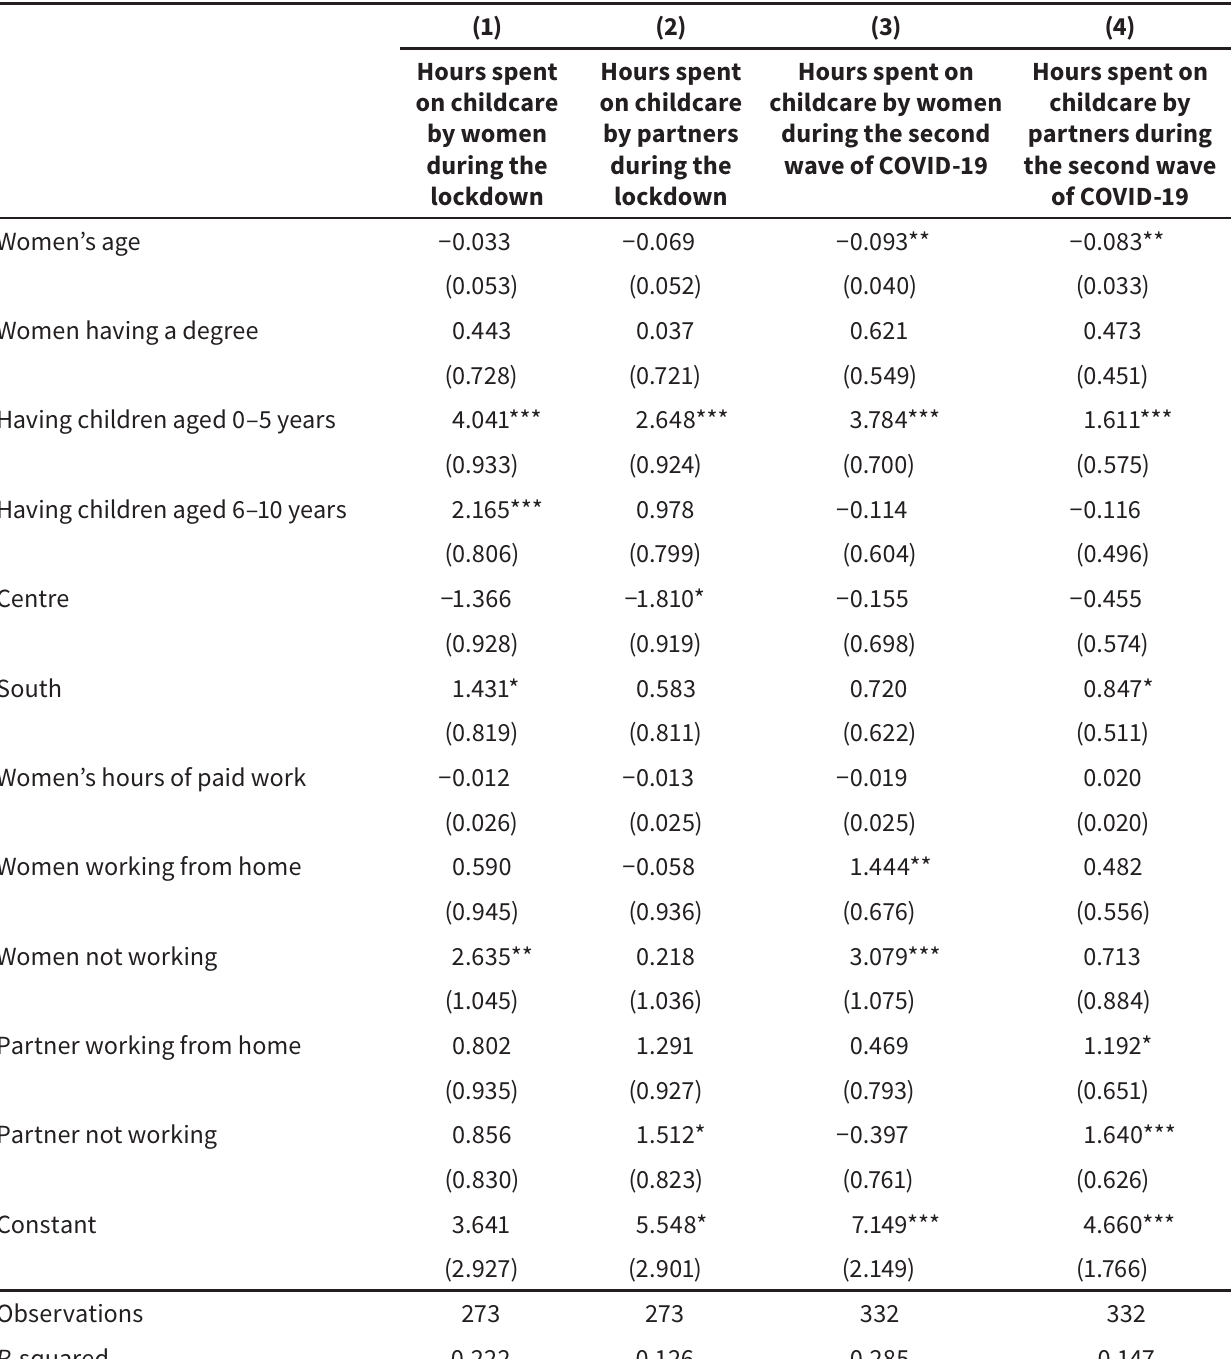
Table 4 Multivariate regression model of hours spent on childcare by women and their partners during the first and second waves of